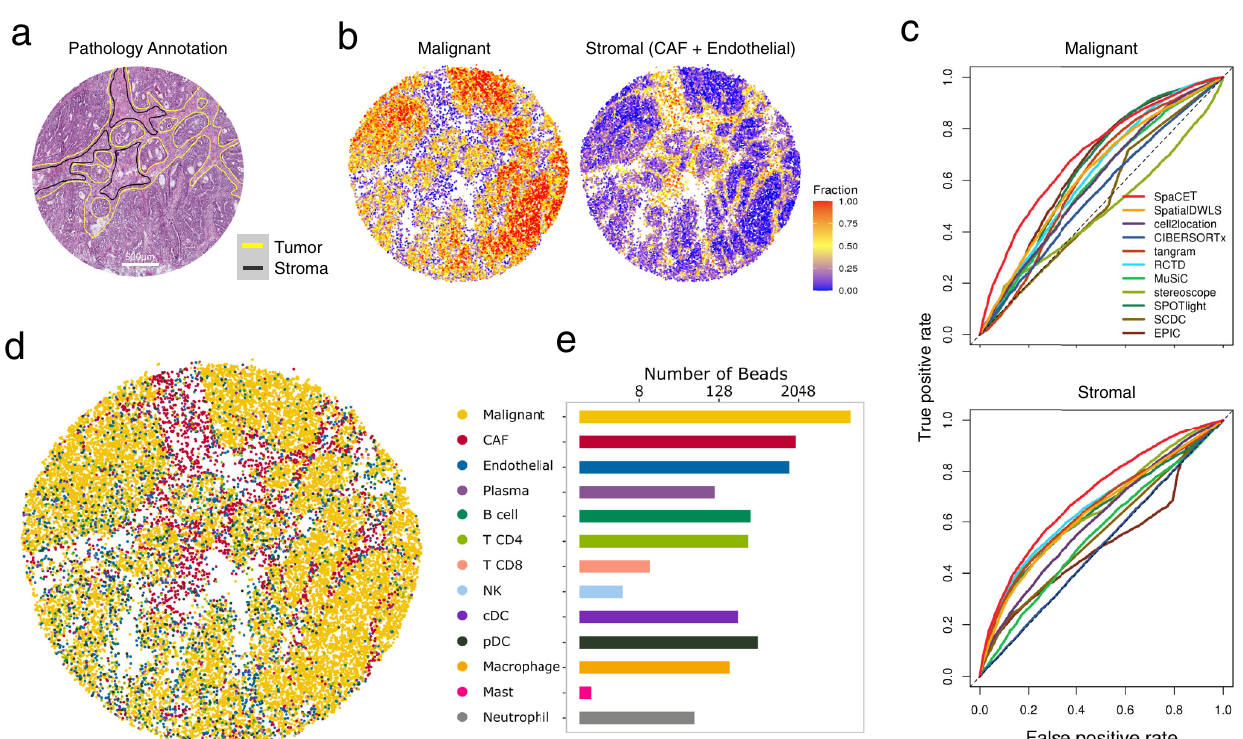
Fig. 4 | Application of SpaCET to a colon cancer Slide-seq dataset. a The H&E- stained image with double-blind pathology annotations. b Fractions of malignant andstromalcells,decomposedbySpaCET. c ROCcurvesofcellfractionprediction